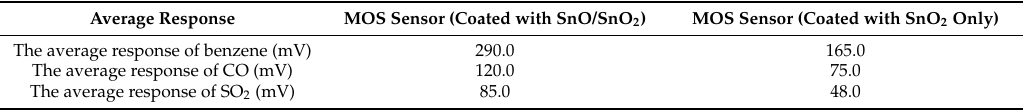
Table 1. The average response of the two sensors to same sample.